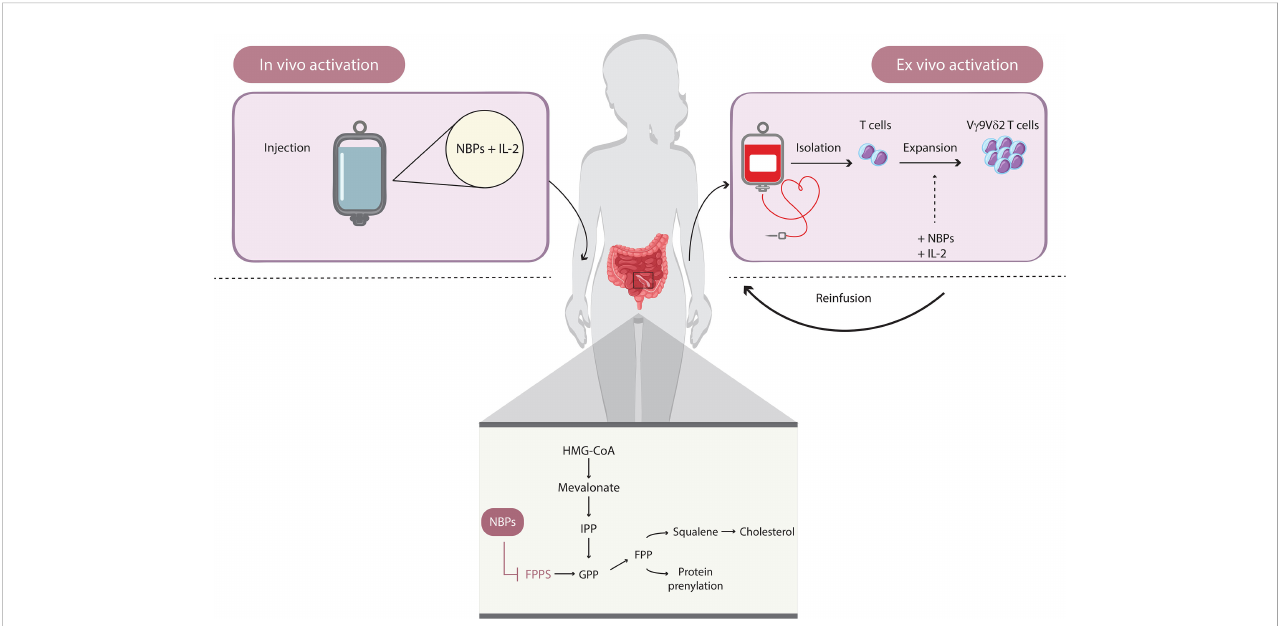
FIGURE 3 How to use gd T cells in immunotherapy. Immunotherapeutic approaches based on V g 9V d 2 T cells involve two types of mechanisms: in vivo activation and adoptive transfer of ex vivo -expanded V g 9V d 2 T cells. The in vivo activation requires the administration of amino bisphosphonates (e.g., zoledronate), which induce the accumulation of endogenous phosphoantigens (P-Ags; such as IPP) by inhibiting the farnesyl pyrophosphate synthase of the mevalonate pathway and upregulating isoprenoid biosynthesis within cells. The ex vivo approach is based on the isolation of gd T cells from peripheral blood mononuclear cells and the activation of V g 9V d 2 T cell, induced directly by natural (e.g., IPP and HMBPP) or synthetic (e.g., BrHPP) P-Ags plus IL-2 and the adoptive